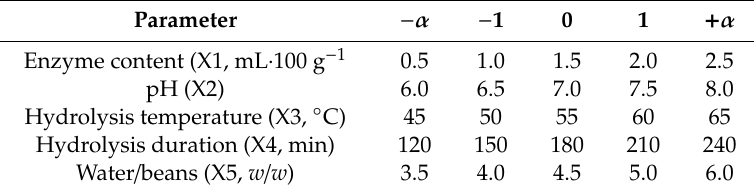
Table 5. Parameters of enzymatic hydrolysis conditions optimization using Alcalase. Parameter − α −